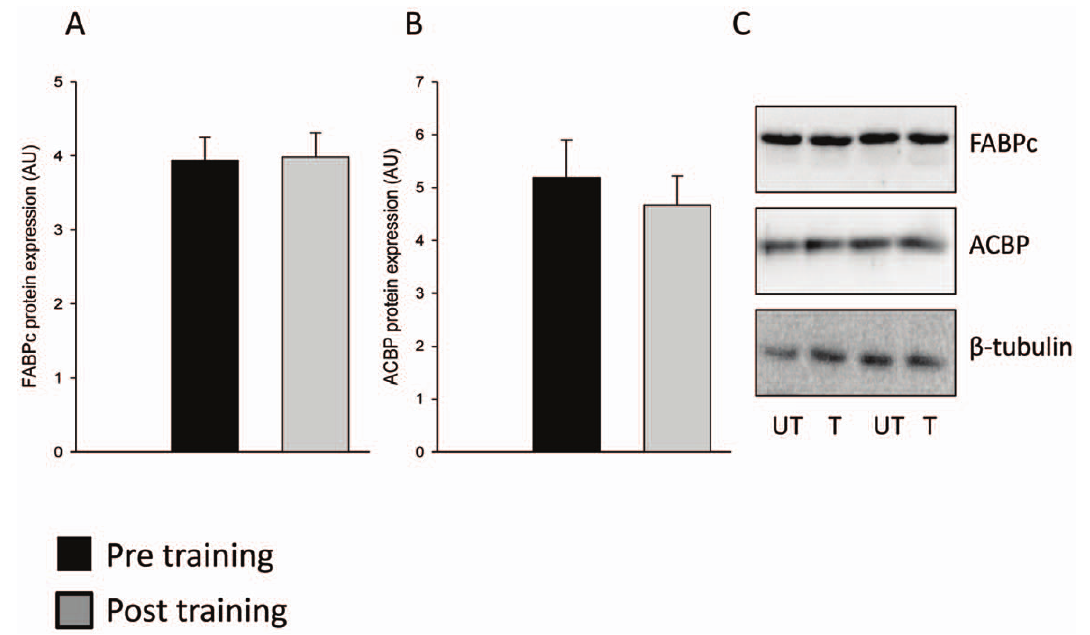
Figure 3. No response of exercise training on soluble lipid binding protein expression in human skeletal muscle. Eight weeks of endurance exercise training did not affect (A) FABPc or (B) ACBP protein levels in human skeletal muscle. Protein concentration of cytosol fractions pre- and post training were determined and equal protein amounts were resolved by SDS-PAGE and membranes were immunoblotted using antibodies specific for FABPc and ACBP. b -tubulin was run on membranes as control and was unchanged with exercise training. Representative Western blots of protein levels before (Pre) and after the exercise training period (Post) from the same subjects are shown (C). Black bars represents pre training values and grey bars represents post training values.